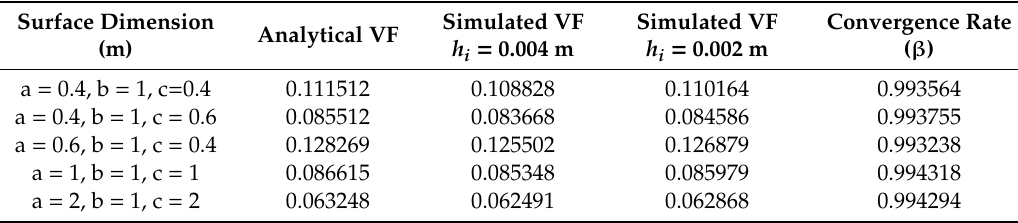
Figure 7. ( a ). Convergence to an analytical solution for a = 2 m, b = 1 m, c = 2 m, and Φ = 120 ◦ . ( b ). Convergence to an analytical solution for a = 0.4 m, b = 1 m, c = 0.4 m, and Φ = 120 ◦ . Table 4. Convergence of the view factor output.